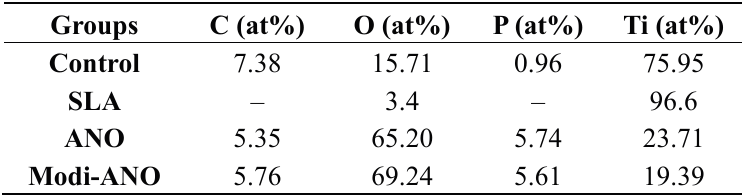
Table 2. EDS surface elemental analysis results.